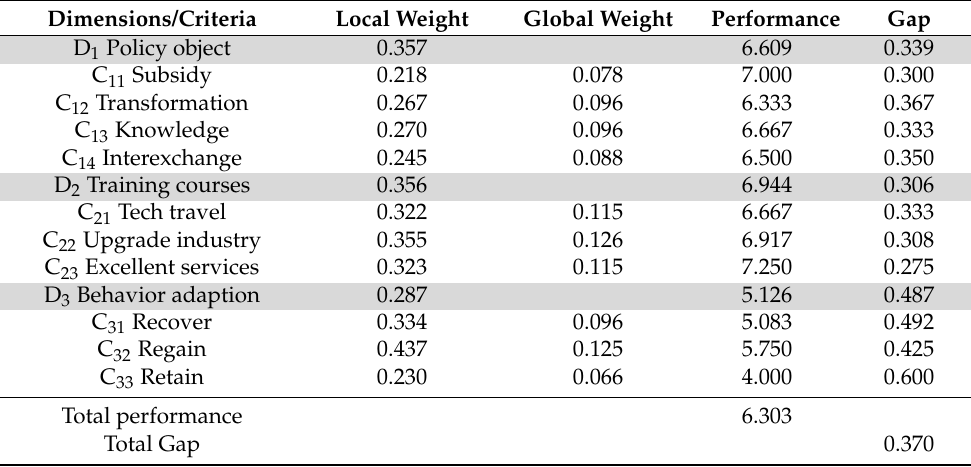
Table 8. The performance evaluation of the case study using the modified VIKOR.